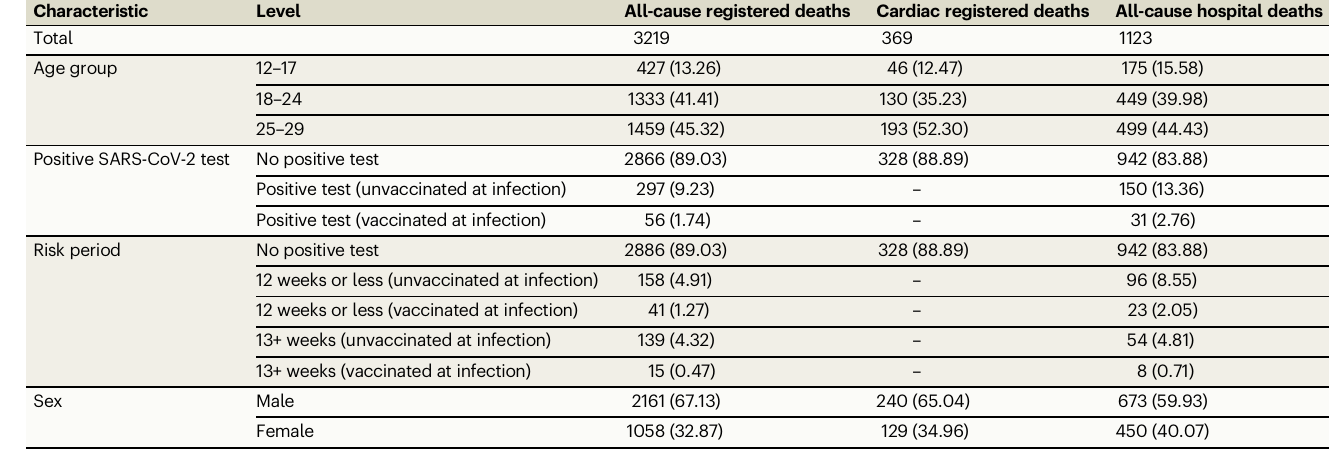
Table 2 | Characteristics of the study population for deaths after SARS-Cov-2 positive test, young people aged 12-29, resident in England, who died between 8 December 2020 - 31 December 2021 for ONS registered deaths and HES hospital deaths. Figures are number (%) unless stated